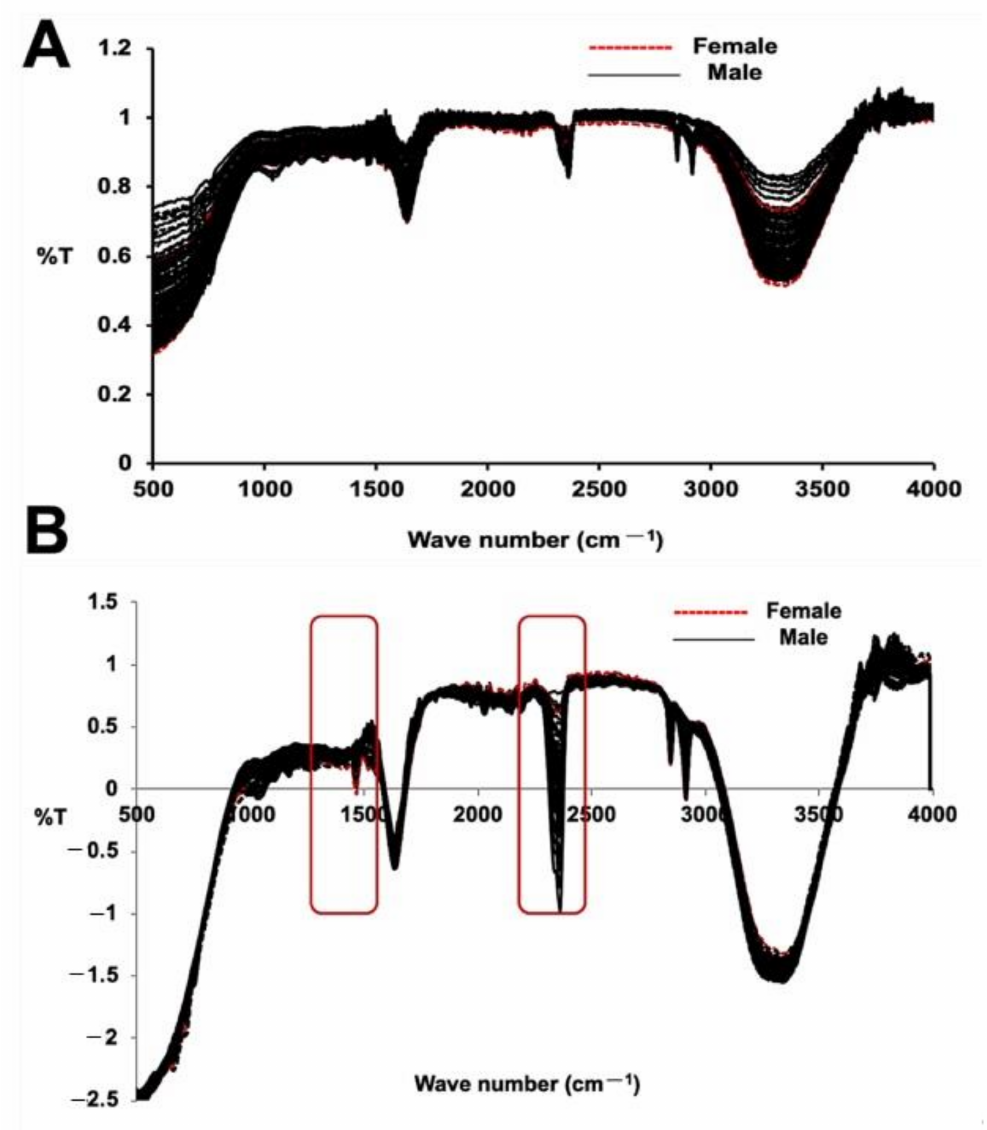
Figure 3. FTIR/ATR analysis for immature date palm leaf samples ( A ) FTIR (ATR) spectra (without pre-processing) and ( B ) pre-processed male and female immature date palm leaf samples. The figure shows the scattering effect due to absorbance without preprocessing in the wavelength range of 400 to 4000 cm − 1 . The spectra represent the fifty individual samples each from male and female and that were tested five times. (Unit vector normalization, SNV, S. Golay 10 smoothing point